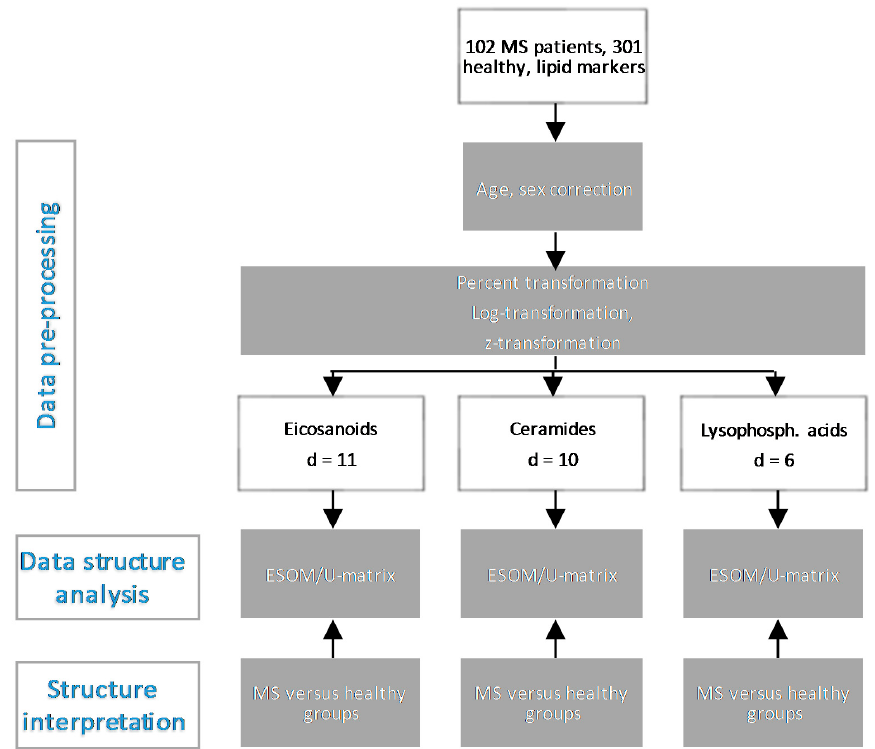
Figure 1. Flow chart of the data analysis. The figure provides an overview on the applied machine-learning approach, which was performed in three main steps (left column of boxes, indicated in blue